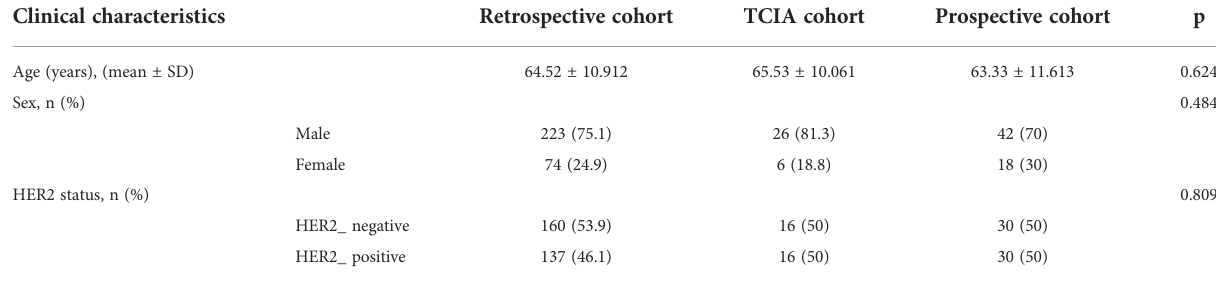
TABLE 2 Patient characteristics in each cohort